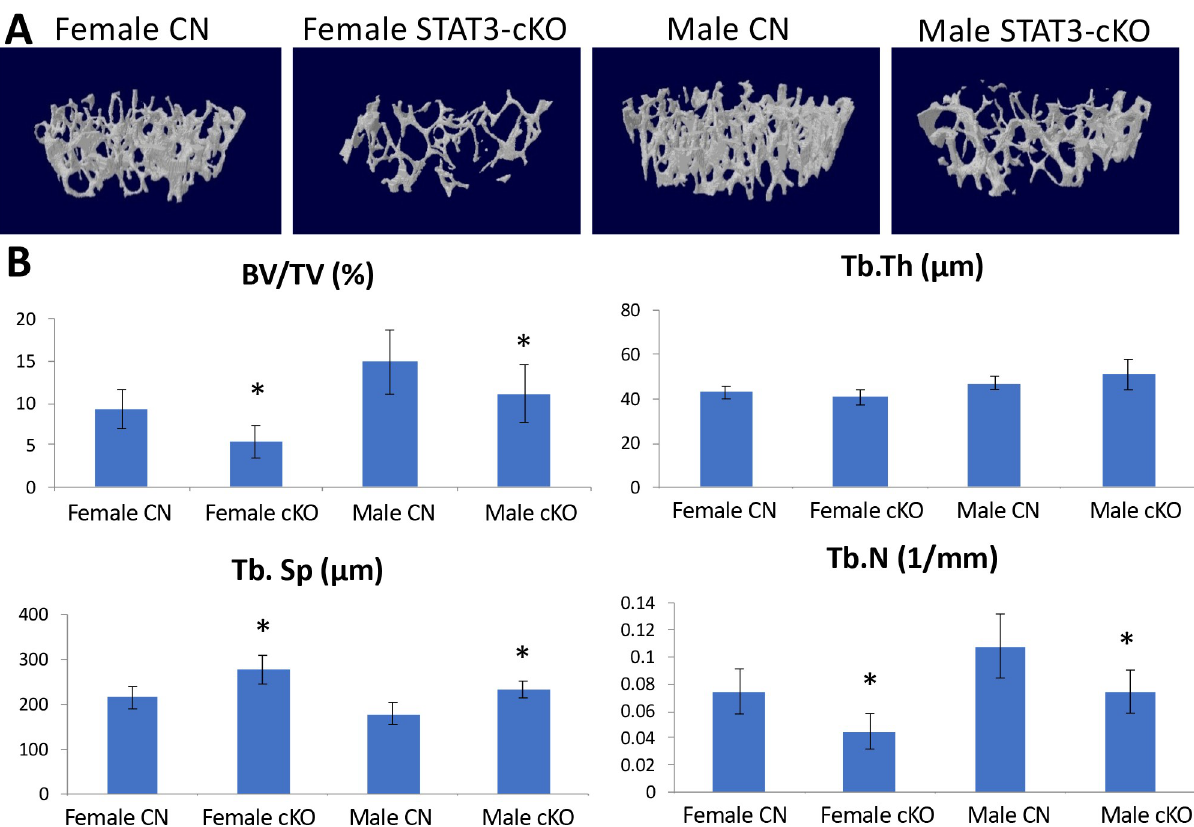
Fig 1. Analysis of the trabecular bone structure of 8 week old femurs from female and male, CN and STAT3-cKO mice. A) Three-dimensional models of a 0.5 mm thick trabecular bone area 1mm proximal from the growth plate. B) Graphs depicting data gathered from the same area. Trabecular number (Tb.N) and bone volume/tissue volume (BV/TV) were significantly decreased in STAT3-cKO males and females compared to age- and sex- matched littermate controls, while trabecular separation (Tb.Sp) was significantly higher in STAT3-cKO female and male mice compared to age- and sex-matched the controls ( � : p < 0.05 compared to sex-matched the control, n = 11-14/group).